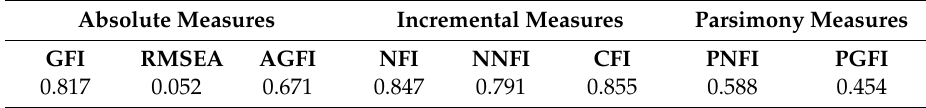
Table 14. GOF measures for the structural model (Source: LISREL output).